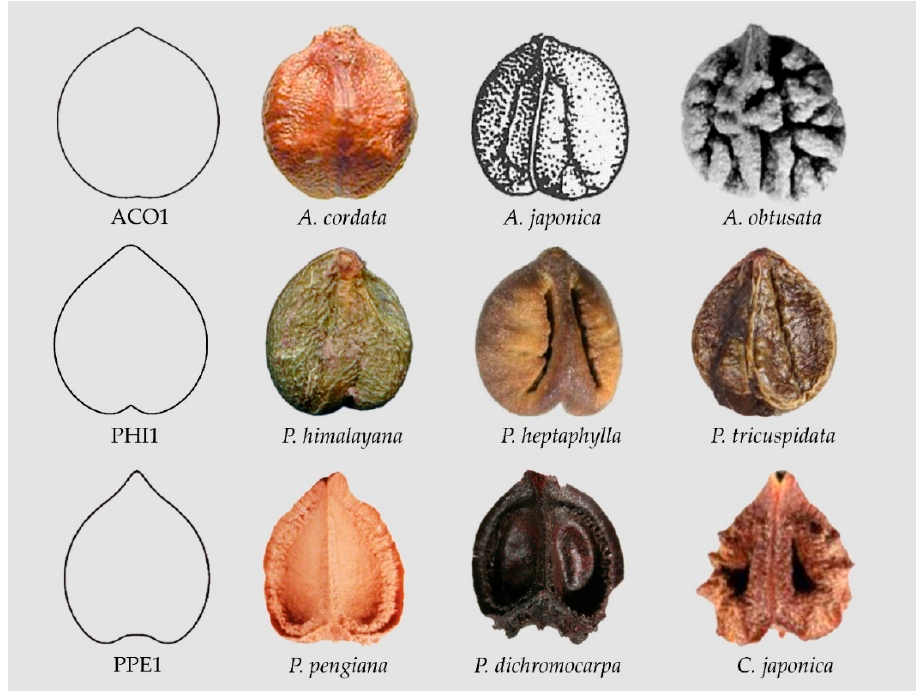
Figure 5. Seeds resembling heart curves. From top to bottom: Model ACO1 ( Ampelopsis cordata , A. japonica , A. obtusata ), Model PHI1 ( Parthenocissus himalayana , P. heptaphylla , P. tricuspidata ), Model PPE1 ( Pseudocayratia pengiana , P. dichromocarpa , Cayratia japonica ).